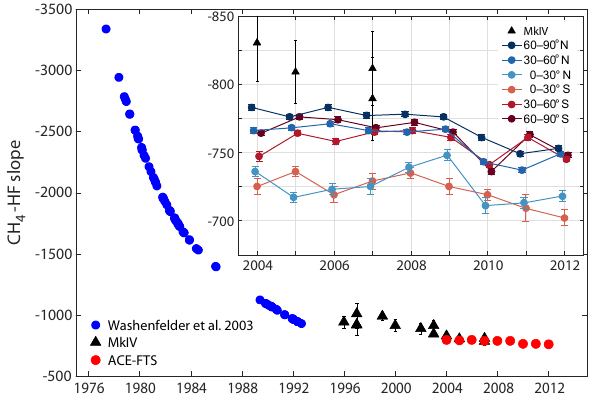
Figure A1. Long-term CH 4 –HF slopes from Washenfelder et al. (2003), MkIV, and updated ACE-FTS measurements. Inset: Time series of zonal pressure-weighted ACE-FTS slopes ( β ) used to cal- culate ˆ X t , with error bars denoting the 2 σ standard error. Zonal CH 4 slopes are offset each year for visual